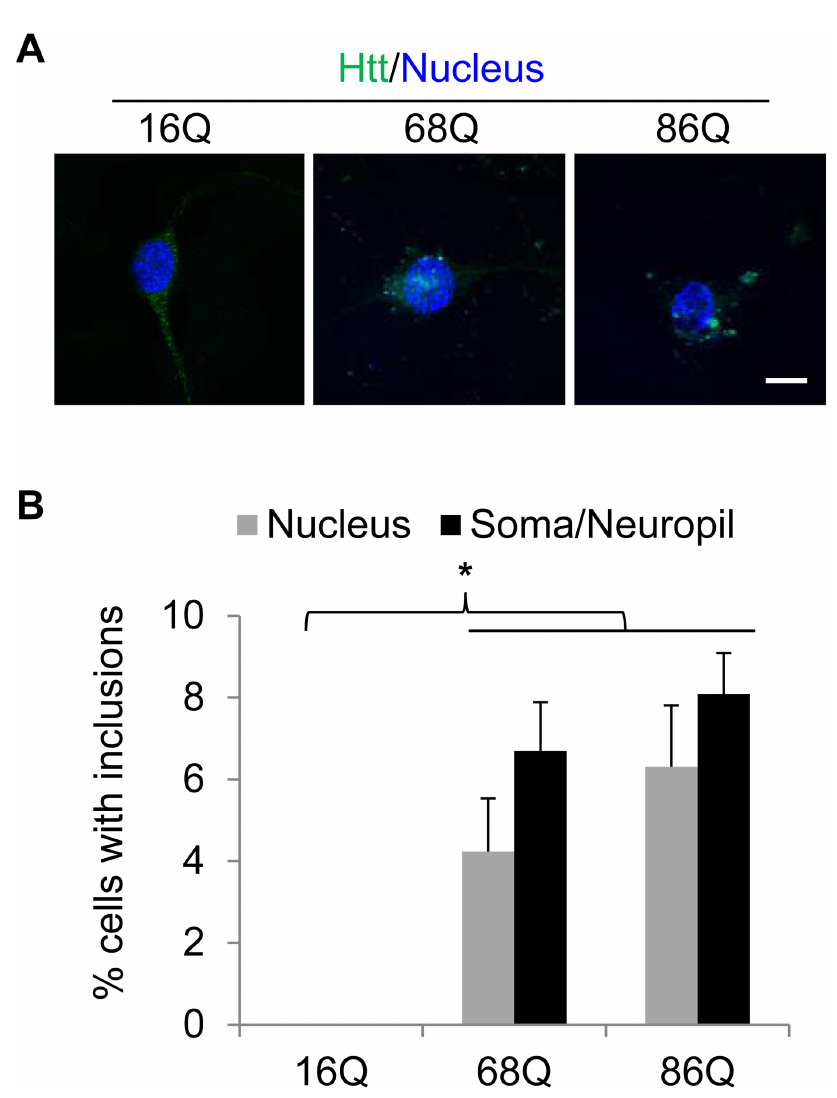
Figure 3. The directly converted HD neuron-like cells show Htt inclusions at nineteen days following PTB knockdown. ( A ) Immunostaining of the trans-differentiated cells with the EM48 antibody indicates the presence of Htt inclusions in the HD cells. Scale bar, 10 m m. ( B ) Cell counting results showing the percentage of cells with aggregates in the nucleus or non-nuclear regions (soma and/or neuropil). Data are shown as mean 6 SD; *p , 0.001. n=3.